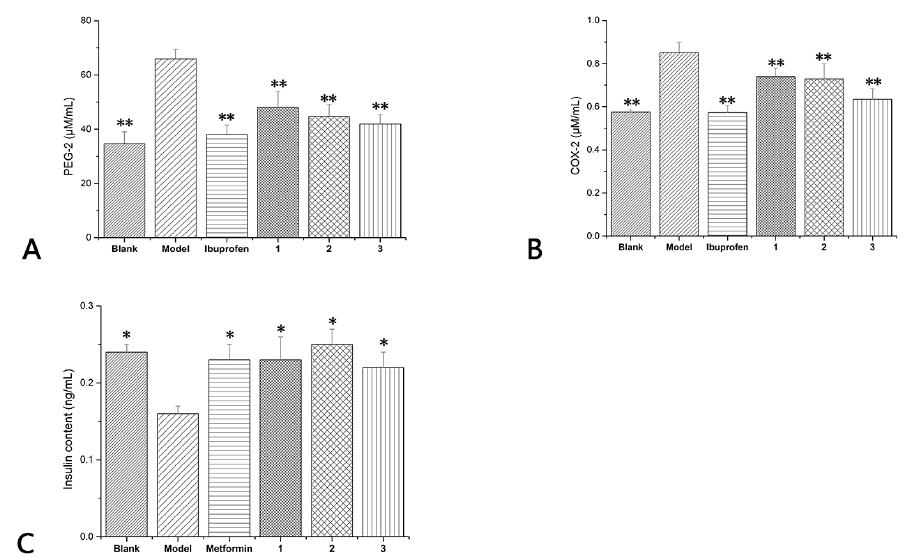
Figure 5. ( A , B ) The levels of COX-2 and PEG-2 which influenced by compounds 1 – 3 and ibuprofen. The blank group was not stimulated by LPS. The model group and compound 1 – 3 groups were stimulated by LPS. * p < 0.05, ** p < 0.01 compared to the model; ( C ) Glucose-mediated (16.7 mM) insulin secretion by INS-1 cells incubated in the presence of compounds 1 – 3 . The blank group was not stimulated by culture medium containing 40 mmol/L glucose. The model group and compound 1 – 3 groups were stimulated by culture medium containing 40 mmol/L glucose. * p < 0.05, ** p < 0.01 compared to the model.